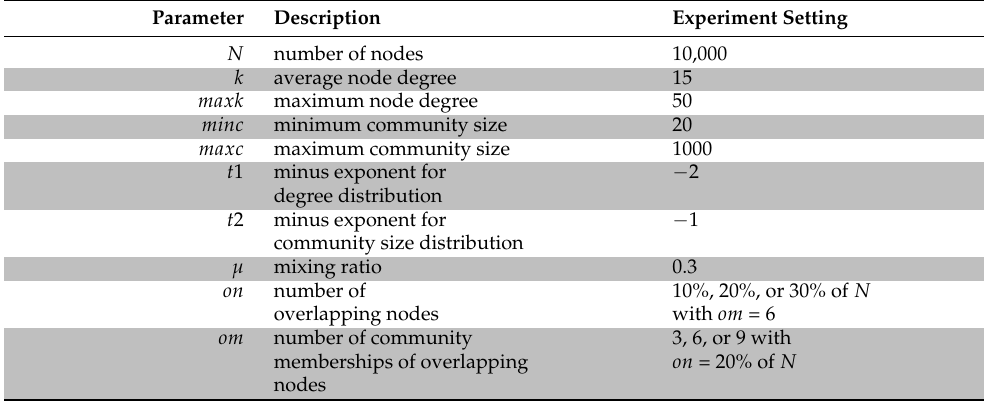
Table 2. LFR parameter settings of synthesized